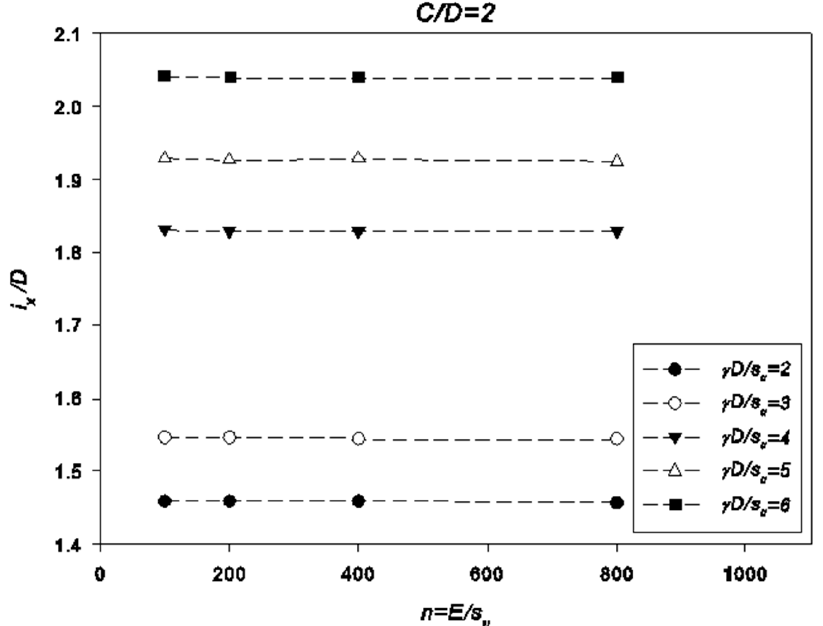
Figure 17. Young’s modulus against i x with respect to γ D/S u .